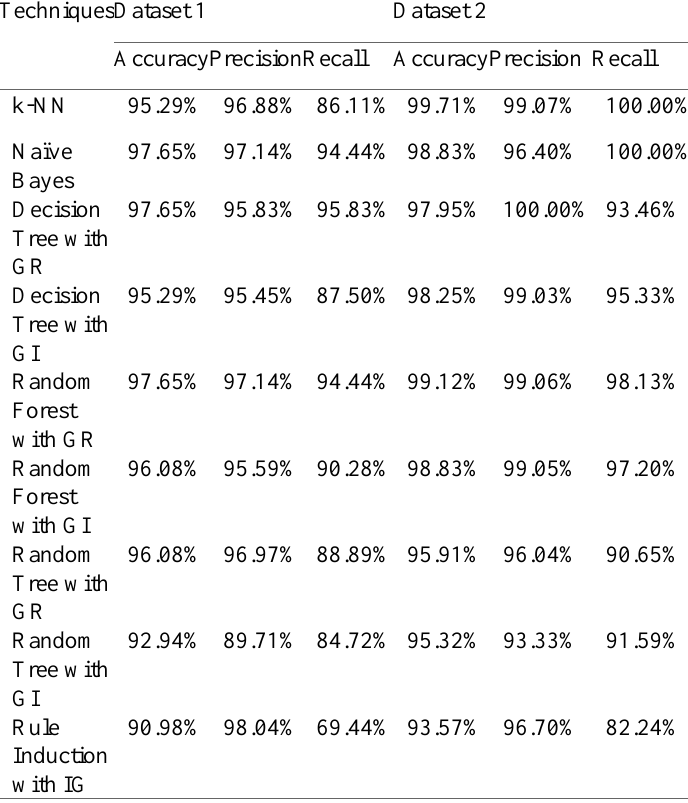
Comparison of Analysis for Non-Technical